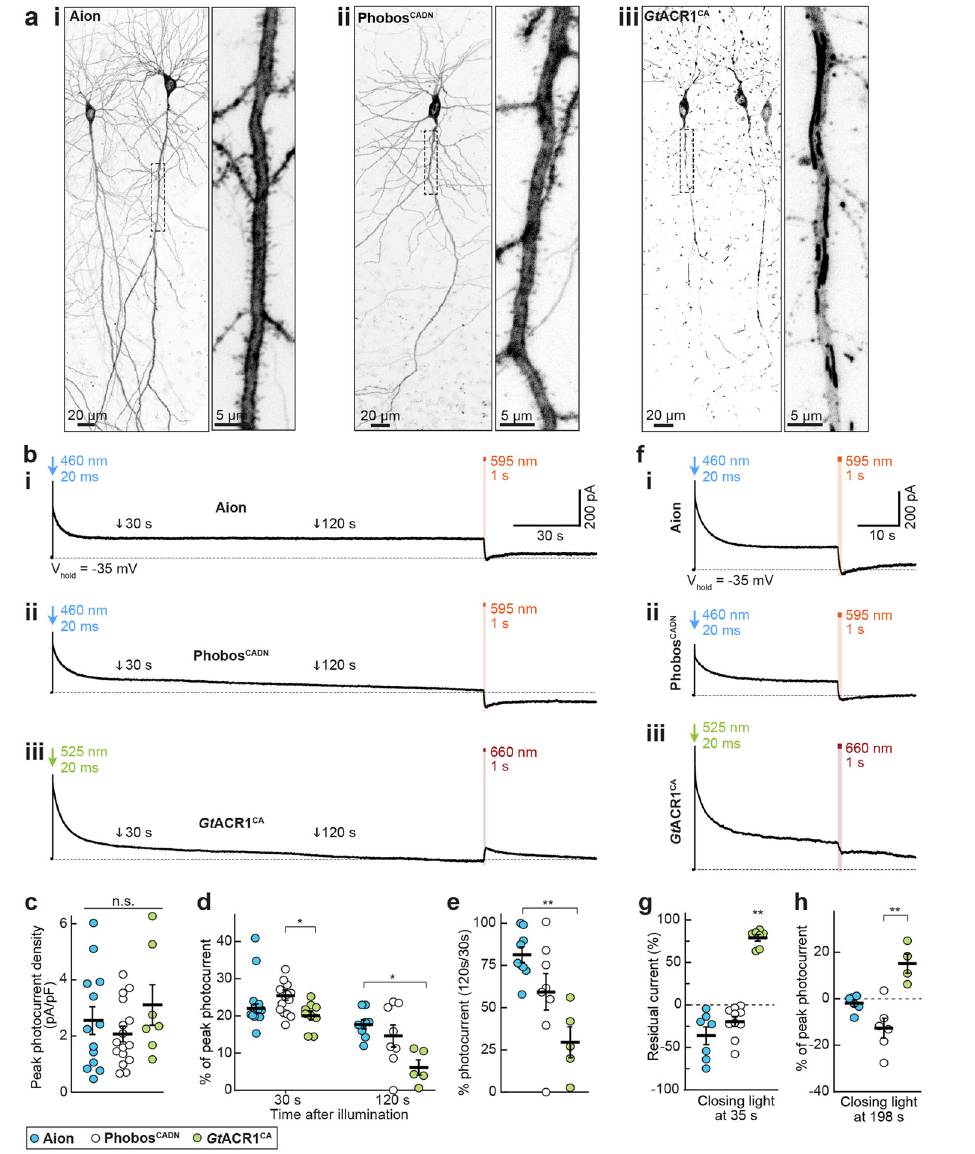
Fig. 2 Expression and photocurrents of Aion, Phobos CADN , and Gt ACR1 CA in CA1 pyramidal neurons. a Maximum-intensity projections of two-photon image stacks showing expression of Aion (i) Phobos CADN (ii) and Gt ACR1 CA (iii) in CA1 pyramidal neurons of rat organotypic hippocampal slice cultures. Fluorescence intensity is shown as inverted gray values. Insets show magni fi ed view of the apical dendrite. b Representative photocurrent traces of Aion (i), Phobos CADN (ii) and Gt ACR1 CA (iii), evoked by a 20 ms light pulse at the respective peak activation wavelength (460 nm for Aion and Phobos CADN , 525 nm for Gt ACR1 CA ) and equal irradiance of 10 mW/mm 2 . Channel closing was accelerated with red-shifted light (1 s, 10 mW/mm 2 , 595 nm for Aion and Phobos CADN , 660 nm for Gt ACR1 CA ) at 198 s after channel opening. Note that red light at 198 s elicited partial opening of Gt ACR1 CA instead of closing, indicated by an outward current after light stimulation. The black arrows at 30 and 120 s after channel opening indicate the time points at which stationary photocurrent amplitudes were quanti fi ed in c – e . c Quanti fi cation of peak photocurrent density for Aion, Phobos CADN and Gt ACR1 CA . d Quanti fi cation of photocurrent amplitude at 30 s and 120 s after channel opening with respect to peak current. e Photocurrent ratio at 120 s compared to 30 s. f Same as ( b ) but channel closing was accelerated 35 s after opening. g Residual current upon channel closing 35 s after opening. Photocurrent amplitude was measured in the 5 s before and after the closing light pulse. h Quanti fi cation of photocurrent amplitude upon channel closing 198 s after opening with respect to the peak photocurrent. For ( c – e , g , h ), mean values± SEM are shown (black lines) together with single measurement data points (circles, n Aion = 13 cells ( c , d left), 9 cells ( d right, e ), 7 cells ( g ), 6 cells ( h ); n PhobosCADN = 16 cells ( c , d left), 8 cells ( d right, e ), 10 cells ( g ), 6 cells ( h ); n GtACR1CA = 7 cells ( c , g ), 9 cells ( d left), 5 cells ( d right, e ), 4 cells ( h )). Kruskal – Wallis test with Dunn ’ s multiple comparisons test, * p < 0.05, ** p <